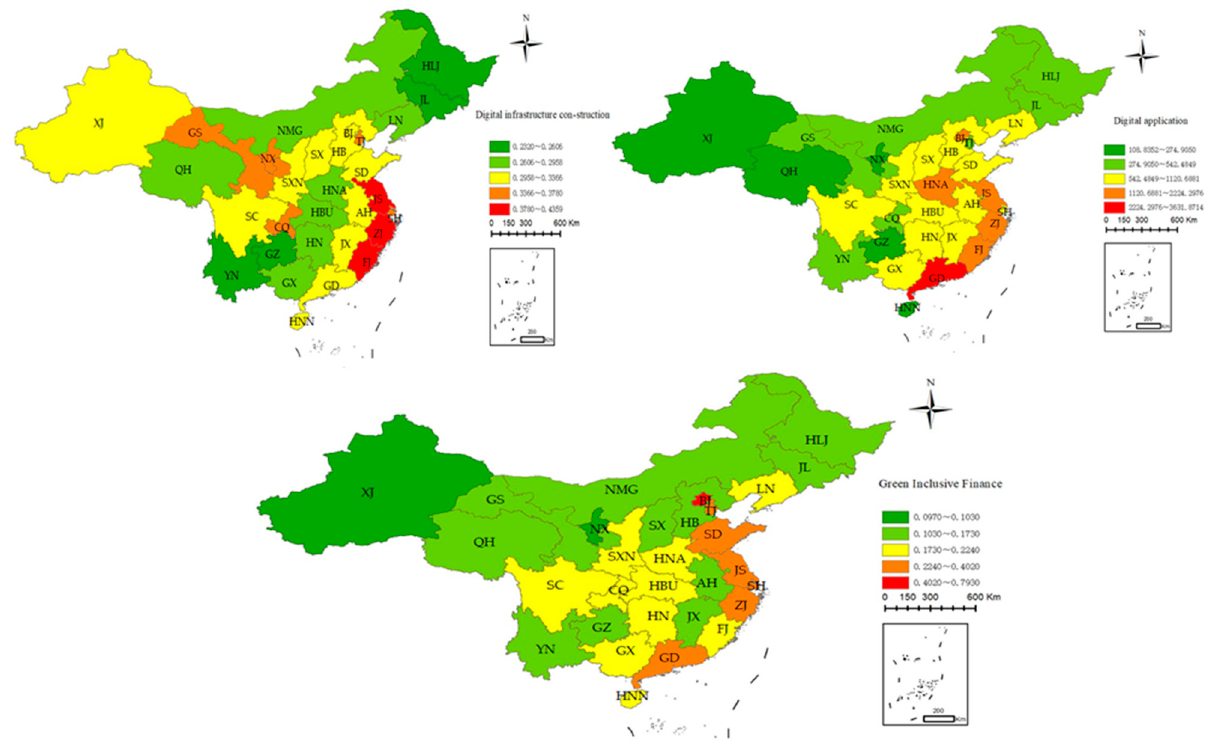
Figure 3. The spatial distribution of digitalization. Note: The upper left, upper right, and bottom graphs reflect the spatial distributions of digital infrastructure construction, digital application, and green inclusive finance, respectively. Table 5. Detection results of global digital drivers from 2010 to